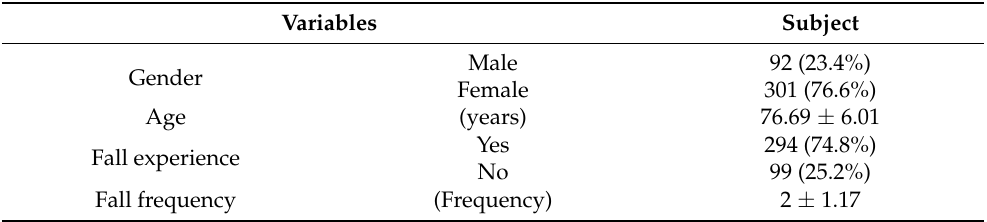
Table 1. General characteristics of the subjects ( n =